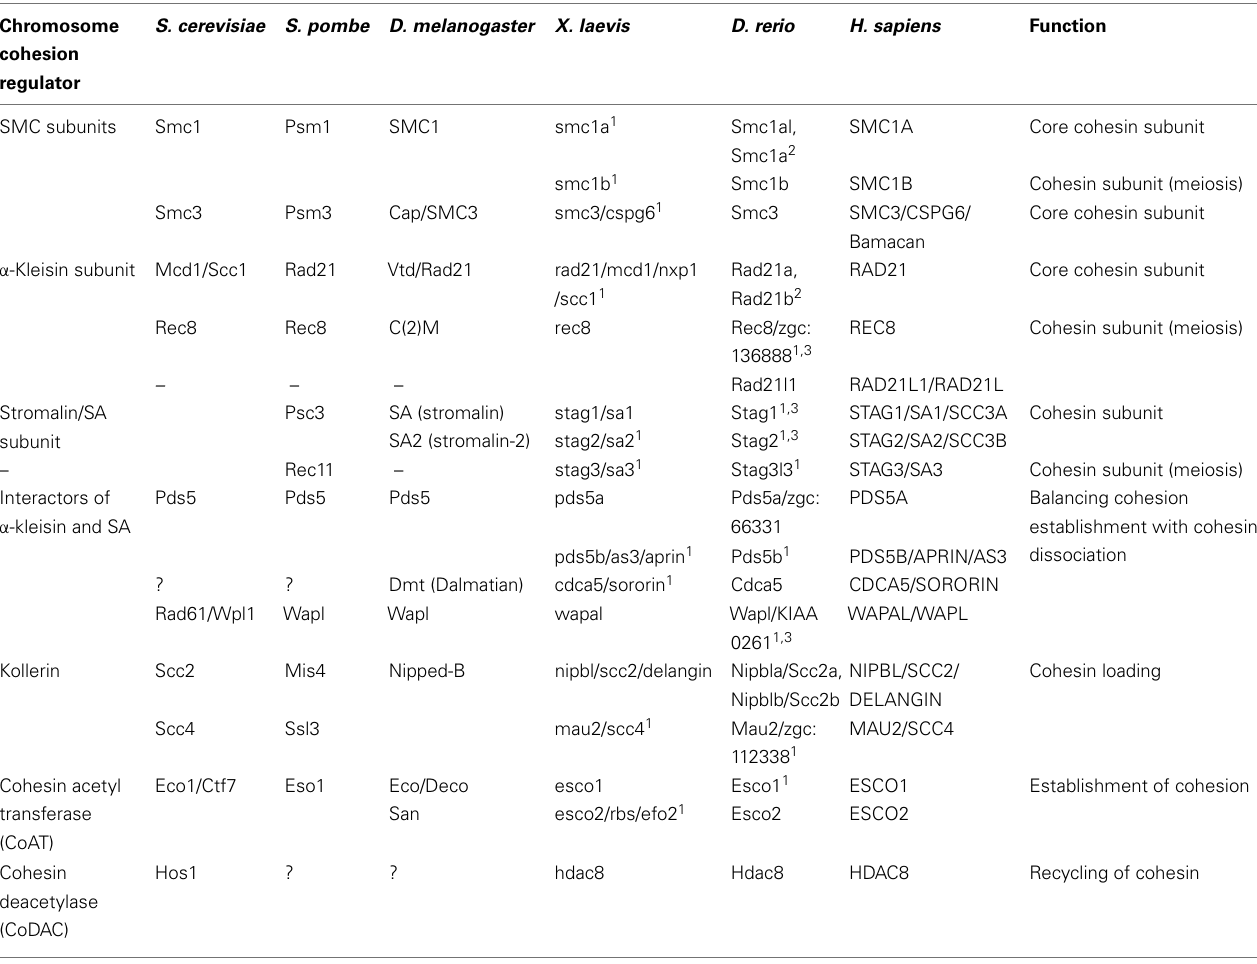
Table 1 | Nomenclature and function of cohesin subunits and cohesin